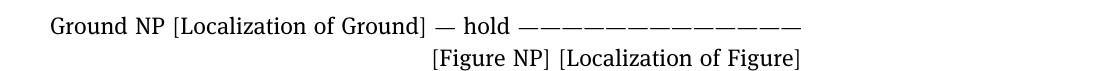
[ Figure NP ] [ Localization of Figure